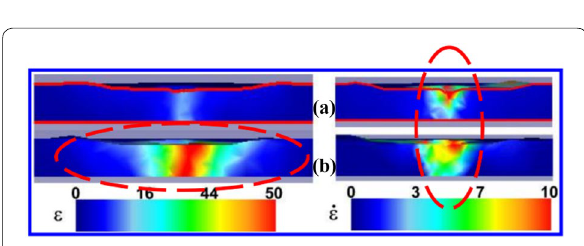
Figure 47 ( a ) Strain and ( b ) stress rate distribution across the workpiece interface [130]